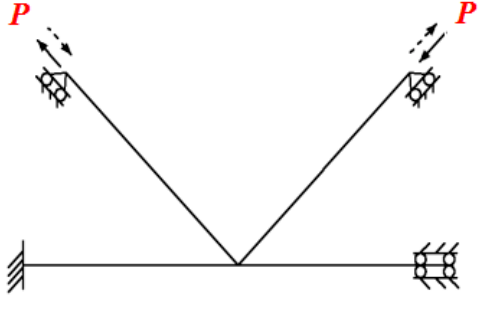
Figure 11. The boundary conditions of the joints.